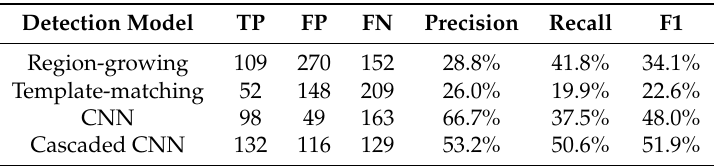
Table 3. The comparisons of Test Area